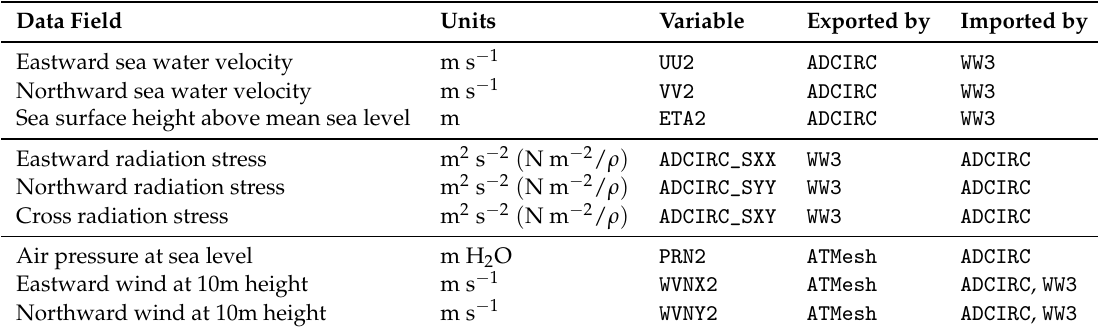
Table 1. Exported and imported fields in a coupled system. All model configurations and results are pre-decisional and for official use only.